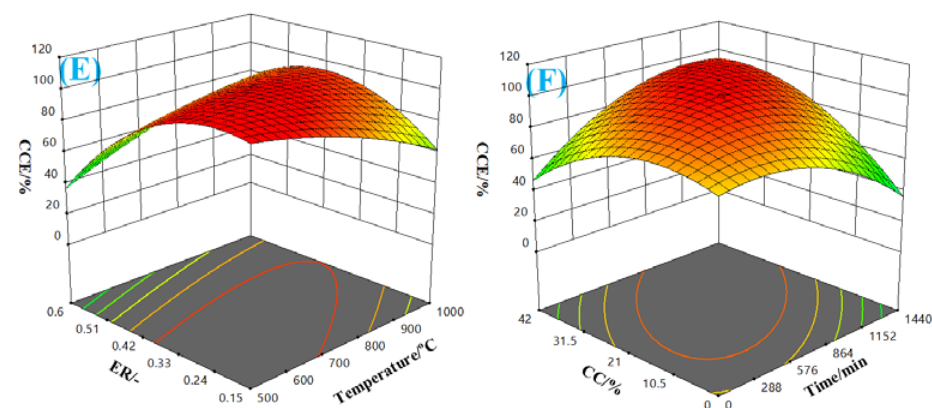
Figure 7. Statistical analysis for the impact of process parameters upon responses, ( A ) SBR ‐ ER ‐ HY, ( B ) PS ‐ ER ‐ HY, ( C ) Time ‐ Temp ‐ HC, ( D ) PS - LHV - HC, ( E ) ER ‐ Temp ‐ CCE and ( F ) CC ‐ Time ‐ CCE.